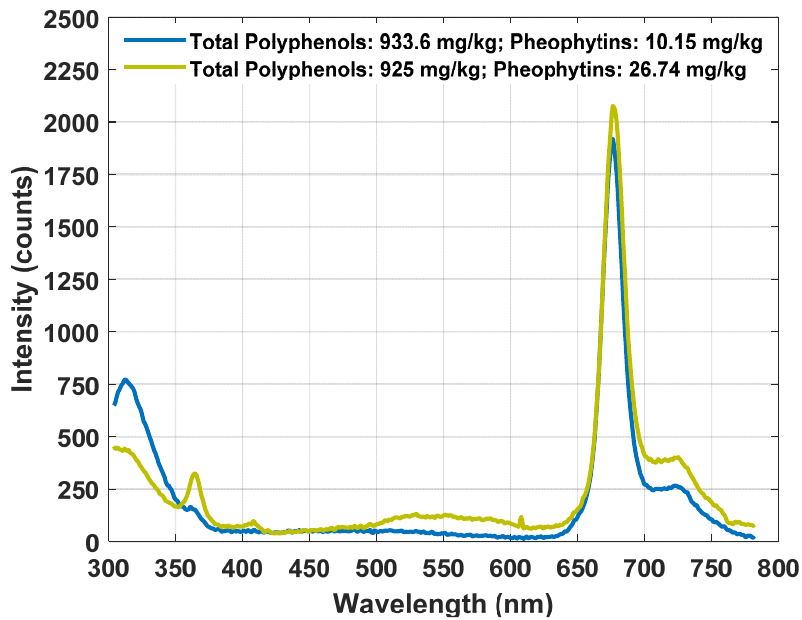
Figure 3. Example of fluorescence spectra of two samples with similar total polyphenol content and different pheophytin content.